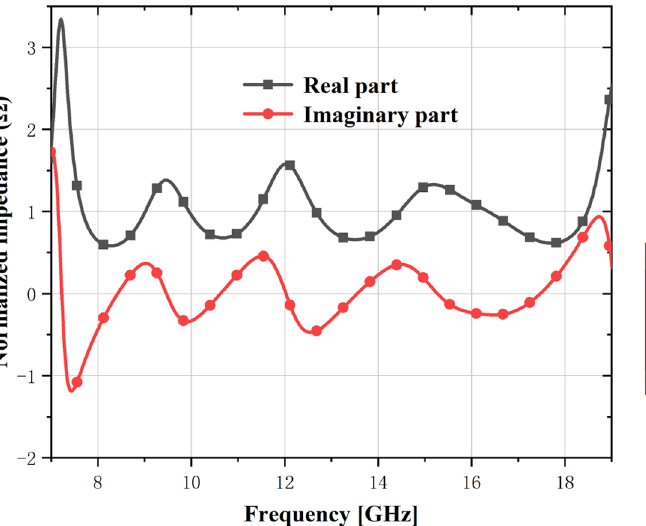
Fig. 2. Normalized impedance of the proposed FSR.